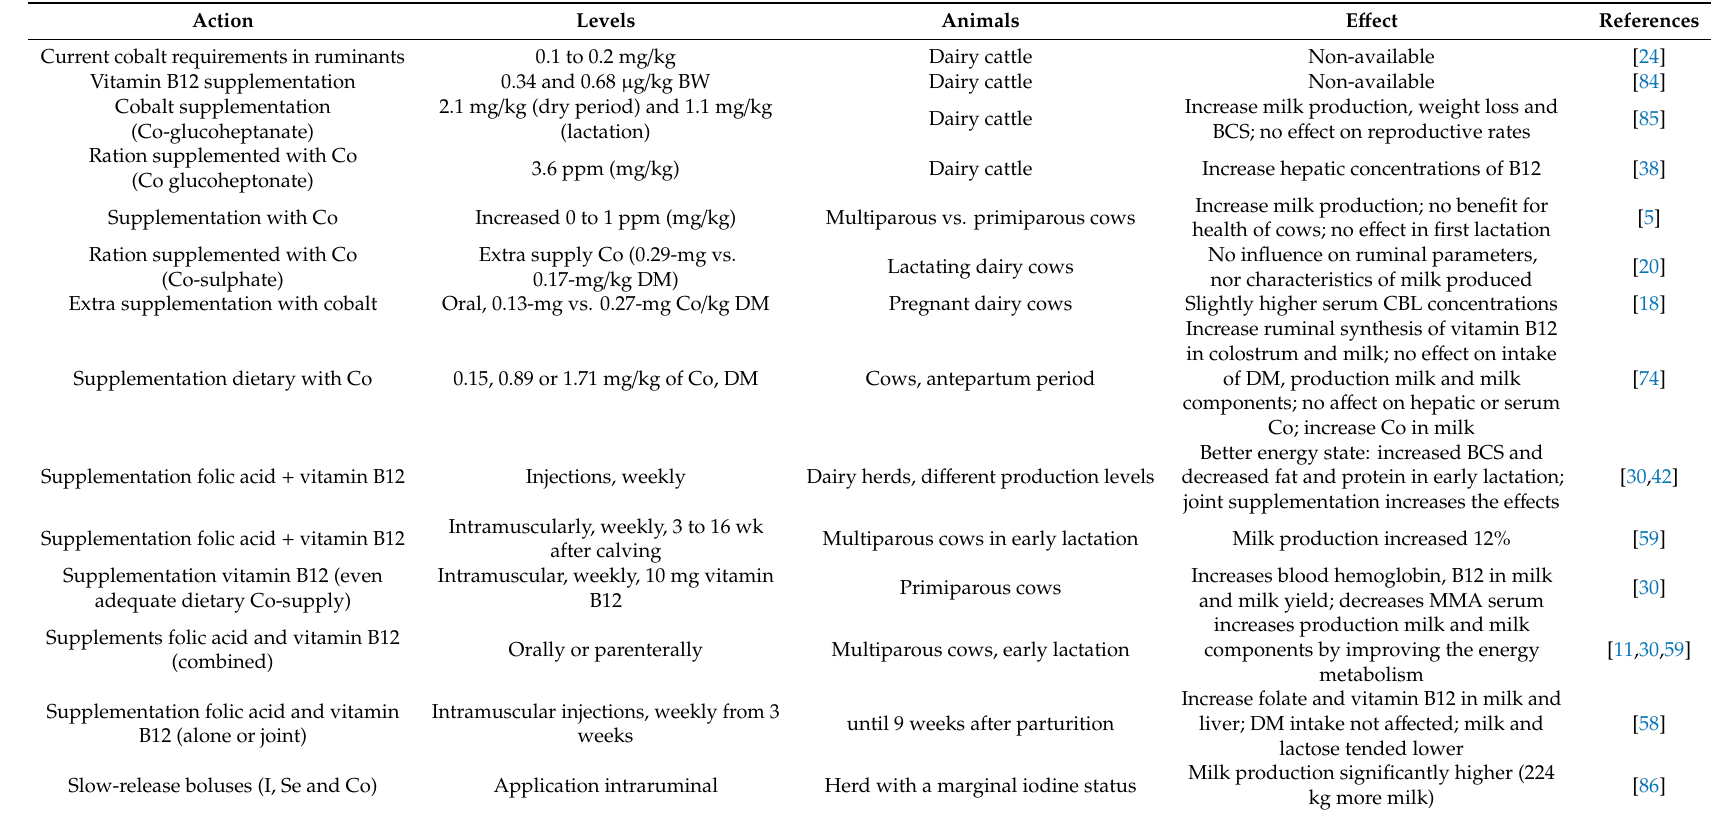
Table 1. Some experiences about supplementations with Co / vitamin B12 in dairy cattle and their most representative e ff ects. BW: body weight, DM: dry matter and CBL: